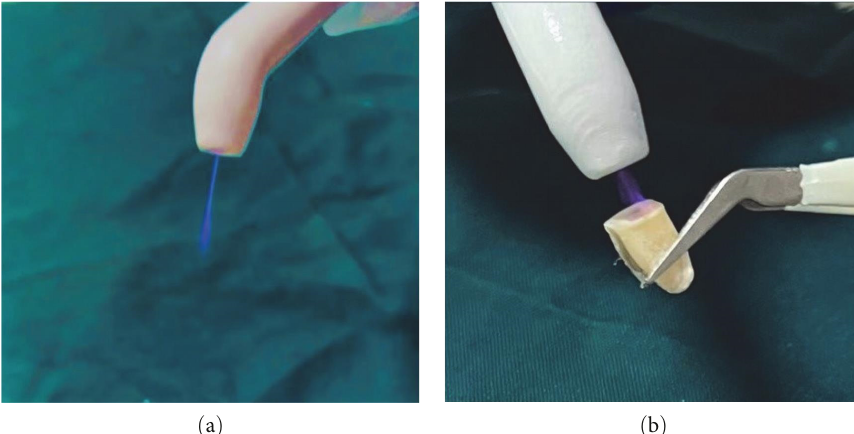
F IGURE 1: Root canal disinfection with CAP: (a) fl ame of device; (b) disinfection of root canals (distance between the nozzle tip and specimen is more than 5mm in this image only for further clari fi cation of the